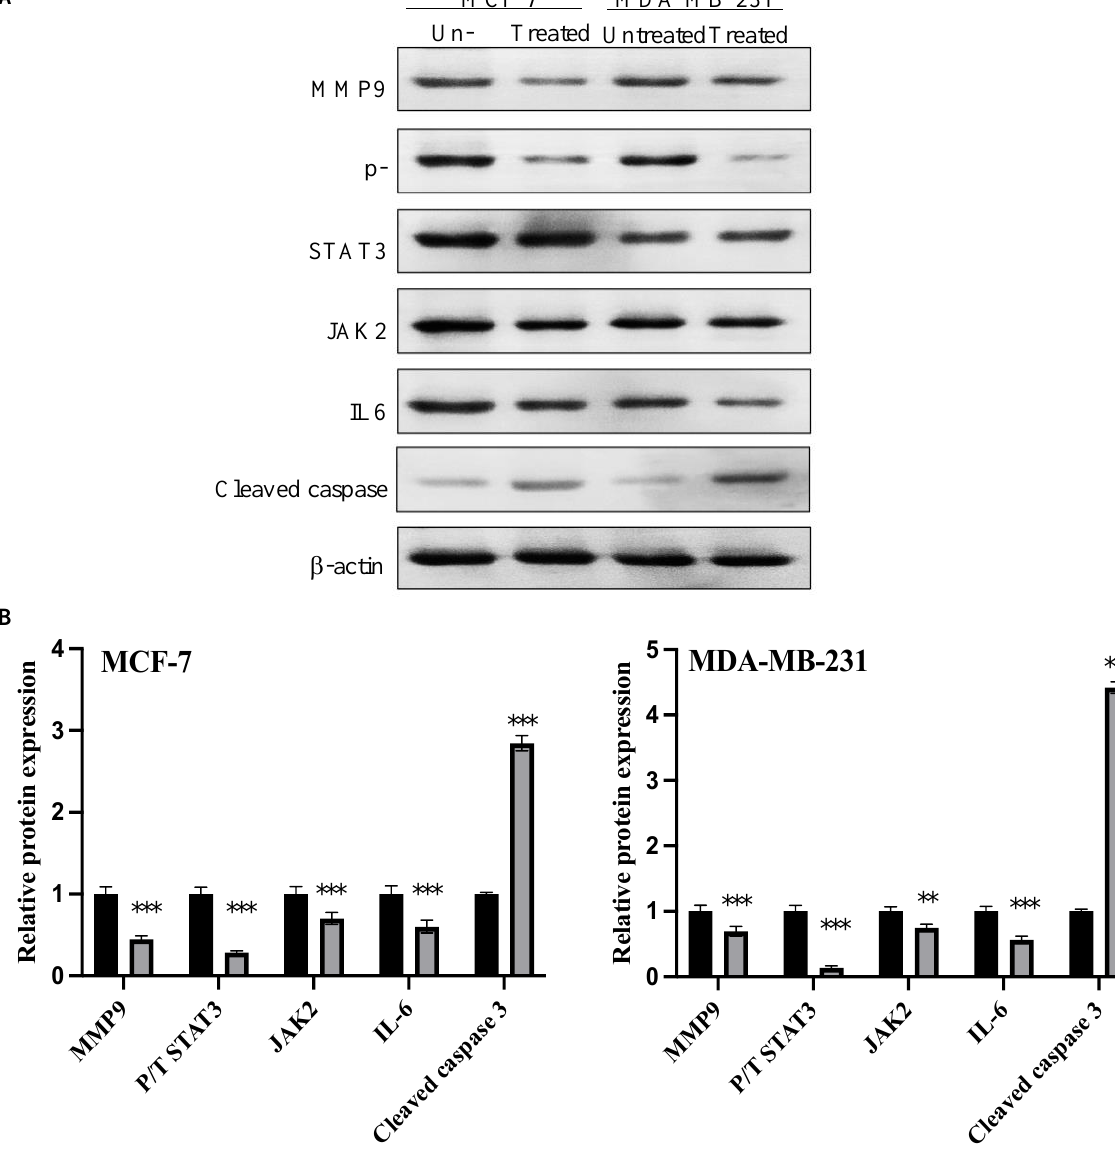
Figure 8. Effect of azilsartan on the expression of MMP9, phosphorylated STAT3, total STAT3, JAK2, IL6 and cleaved caspase proteins in MCF-7 and MDA-MB-231 cancer cell lines. ( A ) Representative western blots of MMP9, phosphorylated STAT3, total STAT3, JAK2, IL6 and cleaved caspase proteins in MCF-7 and MDA-MB-231 cells treated with the IC 50 concentration of azilsartan for 48 h. β -actin was used as internal loading control. ( B ) Expression of proteins in MCF-7 and MDA-MB-231 treated cells were expressed relative to untreated cells after normalization to the corresponding β -actin protein expression. Bars represent mean ± SD, n = 3. Significant difference was analyzed by two-way ANOVA test, where ** p < 0.01, *** p < 0.001, compared to untreated cells.